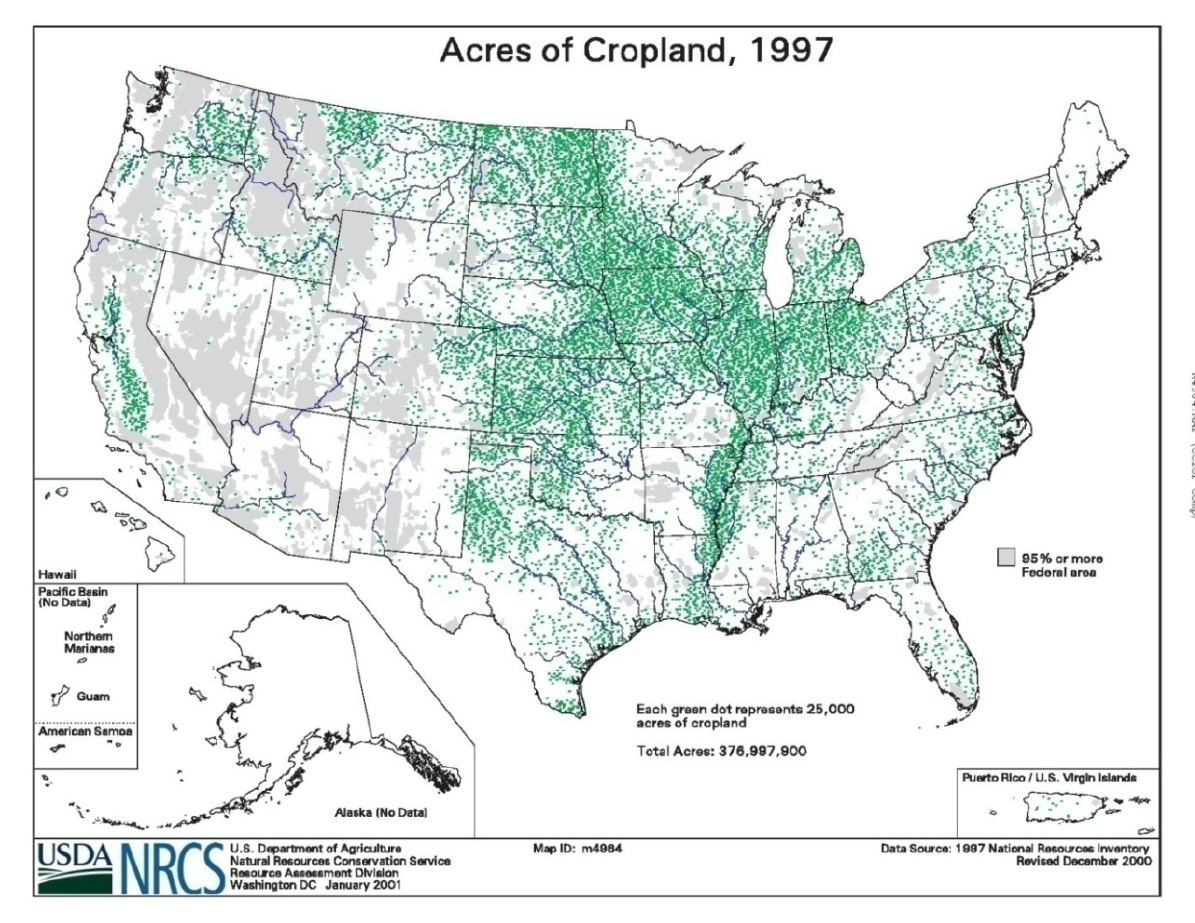
Figure 10. Cropland areas using non-remote sensing approaches with each dot representing 25,000 acres [74]. Cropland areas of USA are determined using various statistical data by NRI. Total cropland areas of USA is 152.56 Mha [74]. Thus about 15.86% of USA’s geographic area (963.1 Mha) are croplands around the year